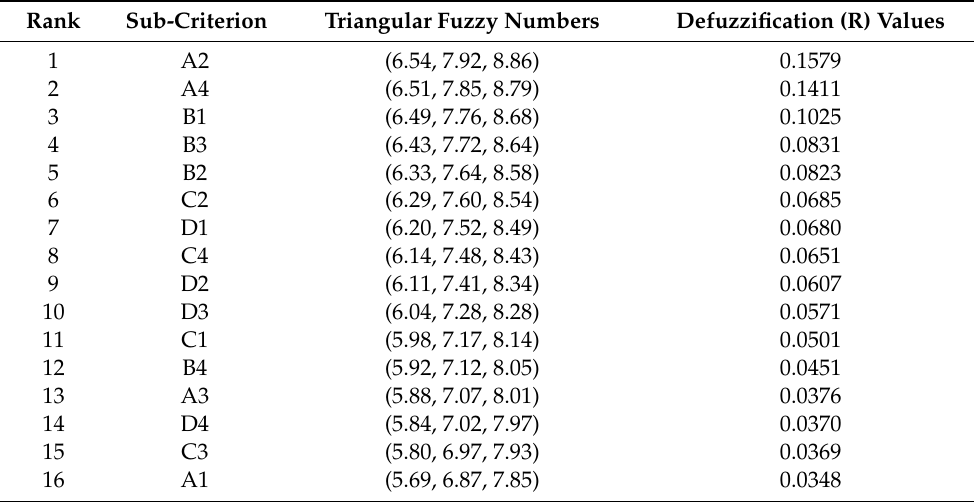
Table 2. FAHP questionnaire analysis result for Taiwanese